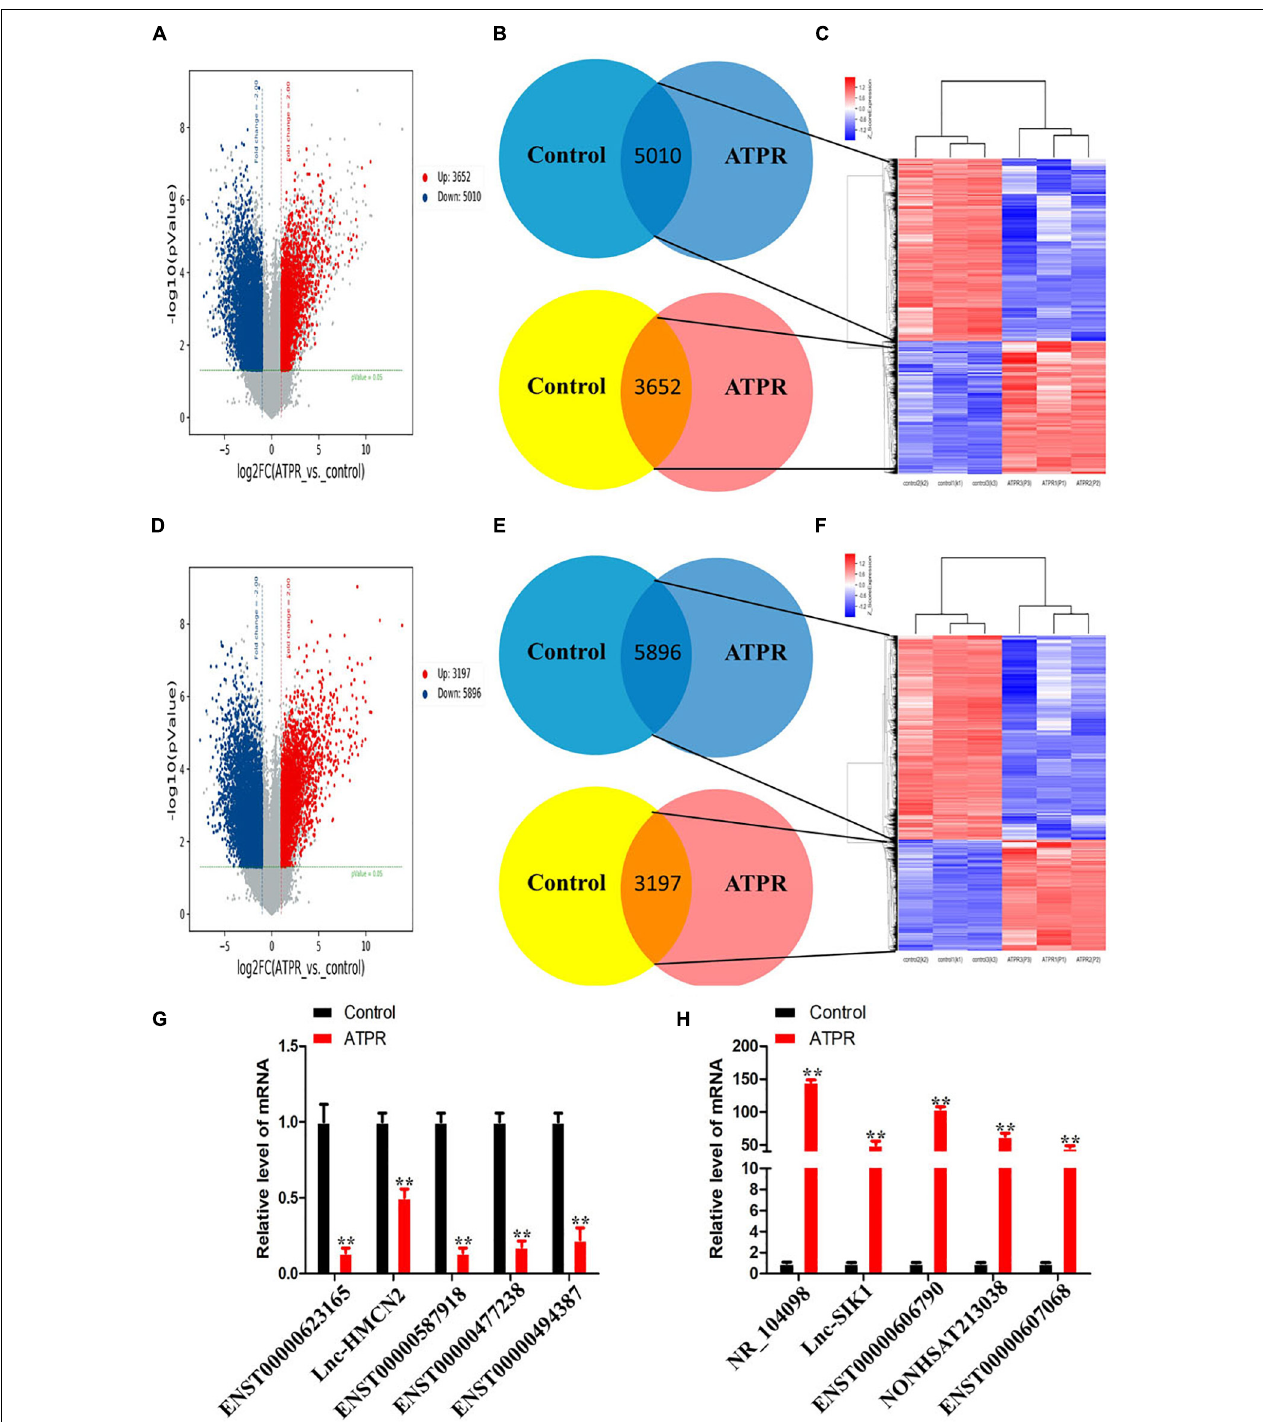
FIGURE 1 | Differentially expressed lncRNAs and mRNAs during ATPR-inhibited NB4 proliferation and induced differentiation. (A) Volcano plots of differentially expressed lncRNAs relative to the control group. (B) LncRNAs that are up- and downregulated throughout ATPR-regulated NB4 proliferation and differentiation. (C) Heat map of lncRNAs up- and downregulated throughout ATPR-regulated NB4 proliferation and differentiation. (D) Volcano plots of mRNAs among those differentially expressed relative to the control group. (E) mRNAs that are up- and downregulated throughout ATPR-regulated NB4 proliferation and differentiation. (F) Heat map of mRNAs up- and downregulated throughout ATPR-regulated NB4 proliferation and differentiation. (G,H) Validation of microarray data using q-PCR. Measurements for (G) five selected down-lncRNAs and (H) five selected